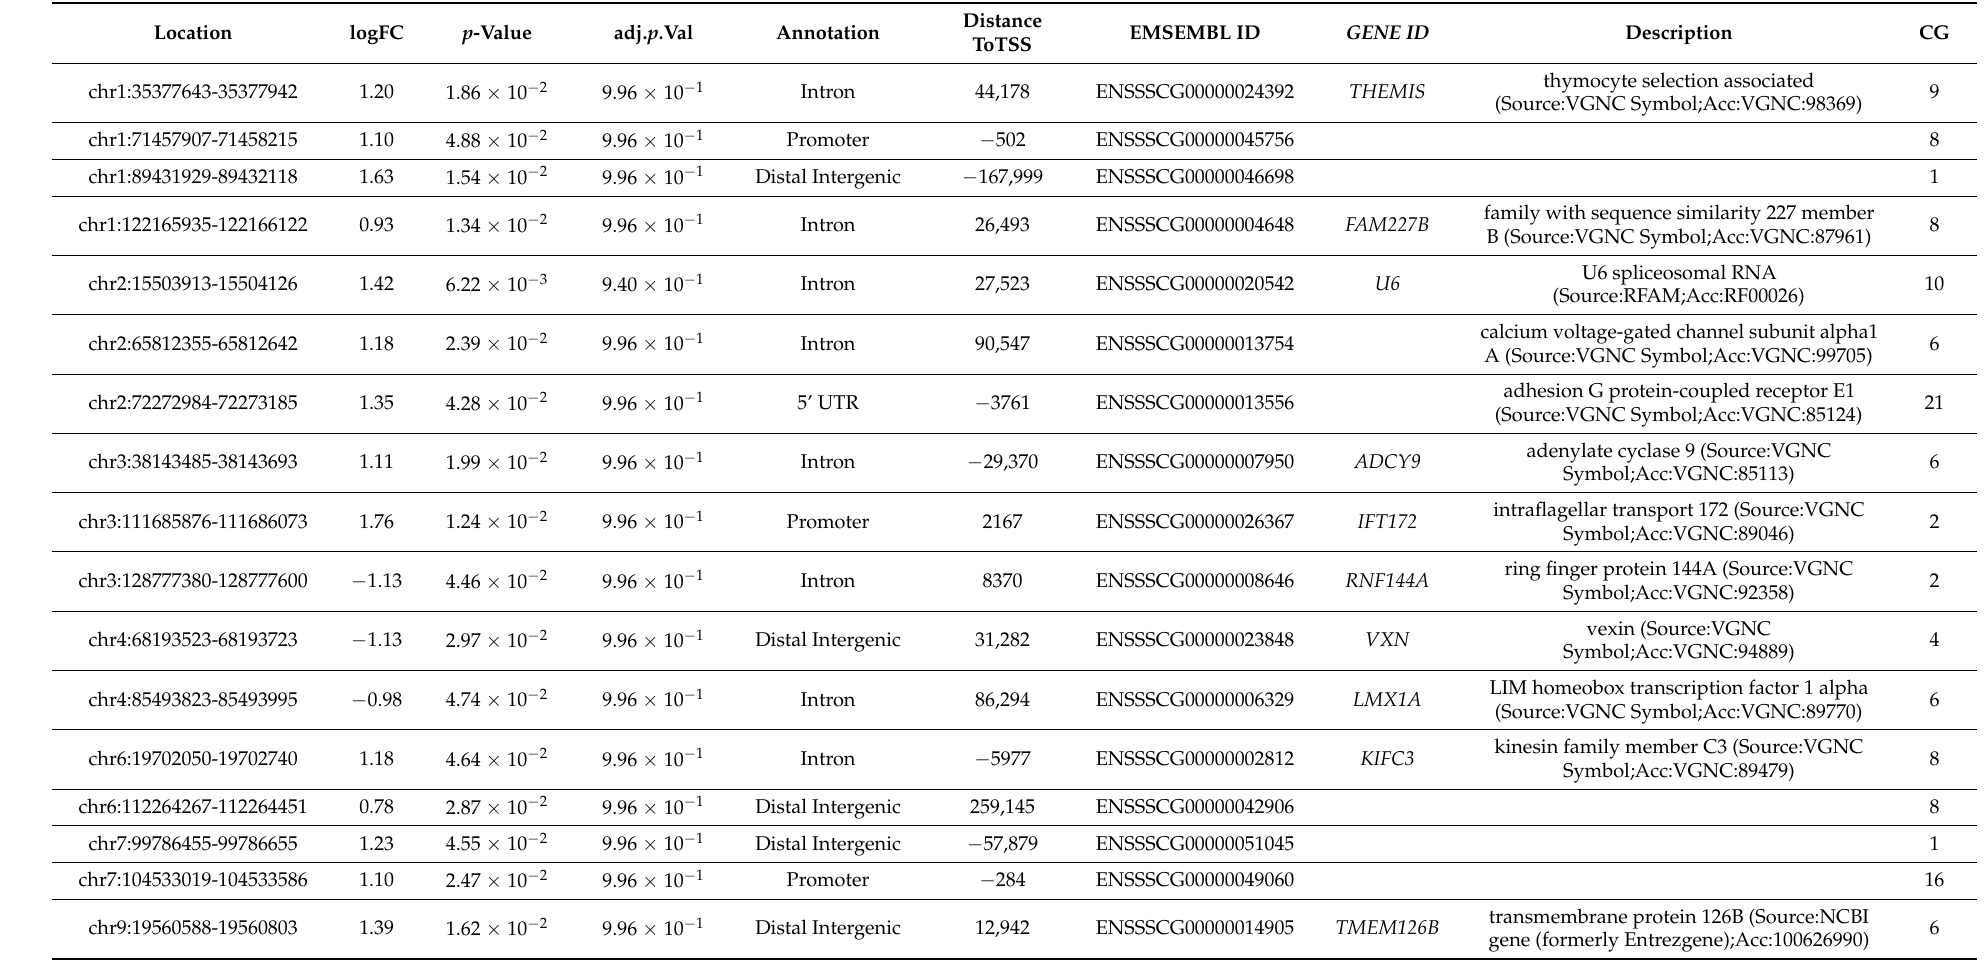
Table 4. Descriptive statistics and gene annotations for the significant fertility-related